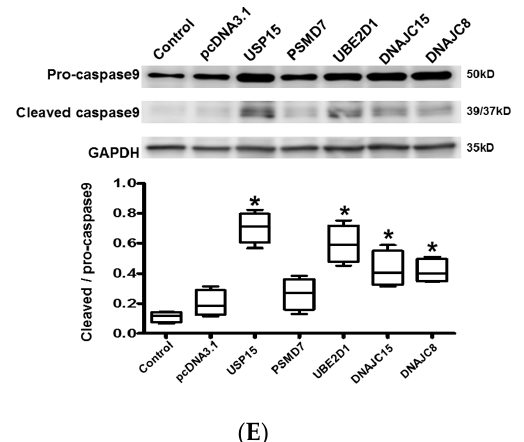
Figure 4. Effects of ubiquitination-related genes on protein ubiquitination and apoptosis in cardiomyocytes. ( A )Box-and-whisker analysis of ubiquitin activating enzyme E1 (UAE-E1) expression in HL-1 cardiomyocytes transfected with USP15, PSMD7, UBE2D1, DNAJC15, and DNAJC8 and their pcDNA3.1 control by ELISA. * p < 0.05 versus control. N = 3 to 5 samples for each group. ( B ) Representative images of cell apoptosis by TUNEL assay. Increased green nuclear fluorescence reflects endo-nucleolytic DNA degradation and apoptosis of HL-1 cardiomyocytes. ( C )Box-and-whisker analysis of cell viability by Cell Counting Kit 8 assay. The relative fold-change was normalized to the group of control. * p < 0.05 versus control. N = 3 to 5 samples for each group.( D ) Representative blots and box-and-whisker Western blot analysis of pro-caspase 3 and cleaved caspase 3. ( E ) Representative blots and box-and-whisker Western blot analysis of pro-caspase 9 and cleaved caspase 9. The relative expression levels of proteins corresponding to GAPDH were quantified by densitometry and normalized to control. * p < 0.05 versus control. N = 3 to 5 samples for each gene.